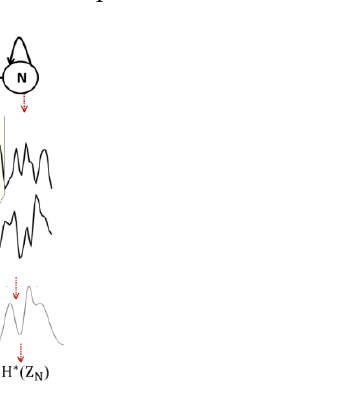
Figure 1. Illustration of multi-channel ( N = 6, D = 2) EEG signal modeling with HMM [69].